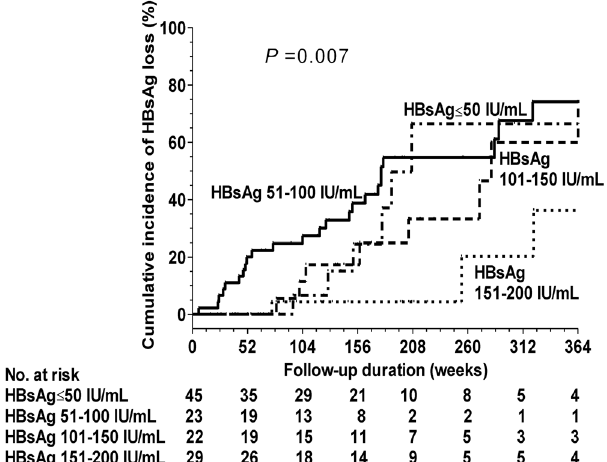
Figure 3. Cumulative incidence of HBsAg loss according to end-of-treatment HBsAg